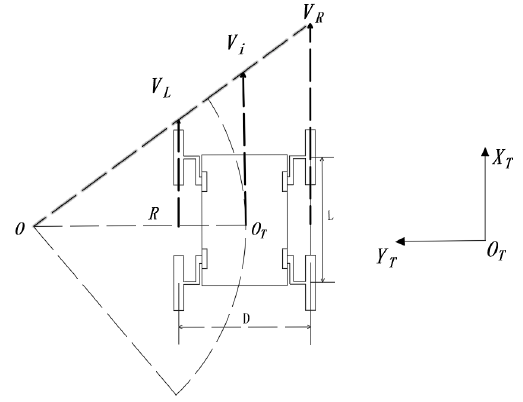
Figure 3. Large radius turning process.